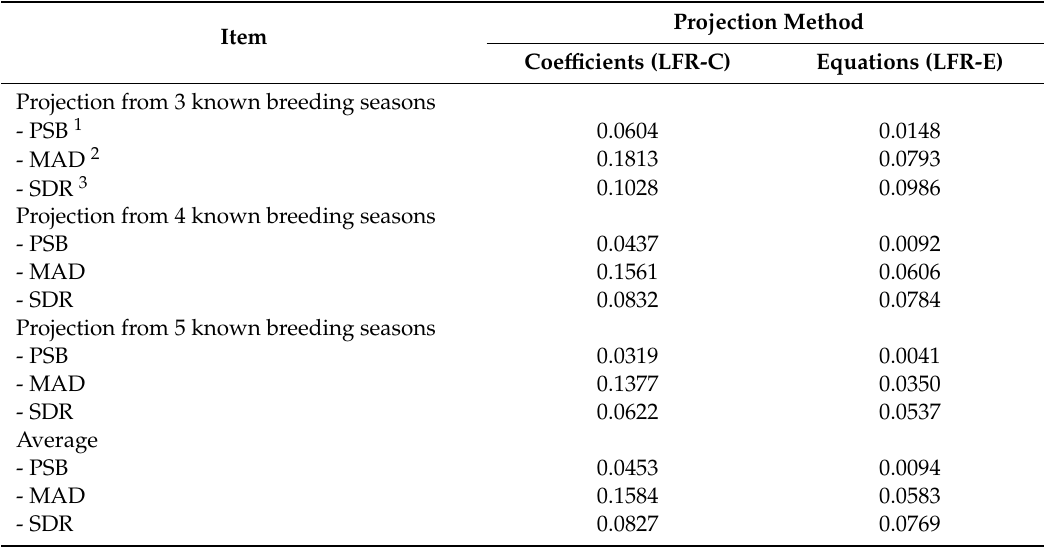
Table 2. Predictive ability of coe ffi cients or equations projection methods used to estimate the foals production at the 6th breeding season and to obtain the lifetime fertility rate (foal produced divided by the number of opportunities) starting from foals produced after 3, 4, or 5 known breeding seasons or considering the whole predictive ability of